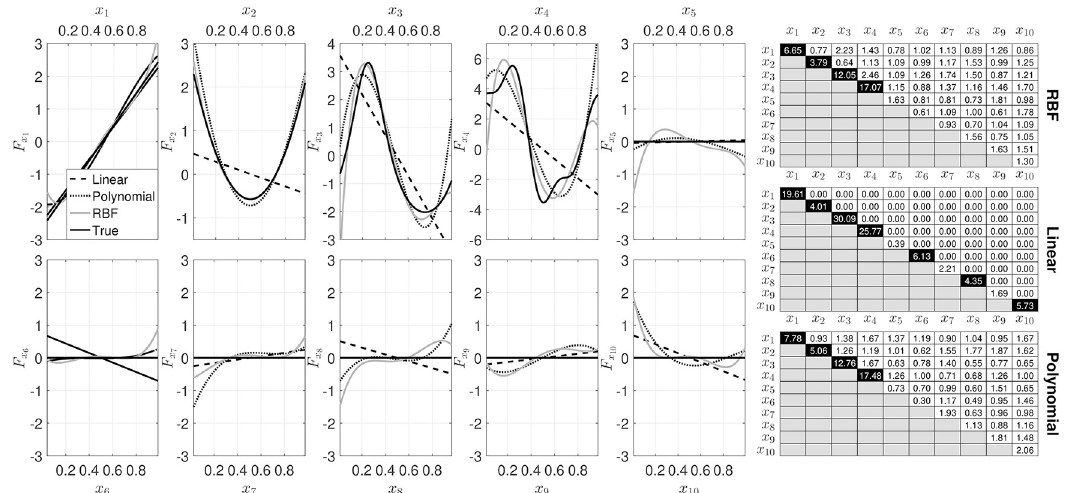
Fig 3. Output of NObSP using different kernels, in black dashed line for the linear kernel, in black dotted line for the polynomial kernel, and in gray solid line for the RBF kernel. The black solid line represents the true contribution.